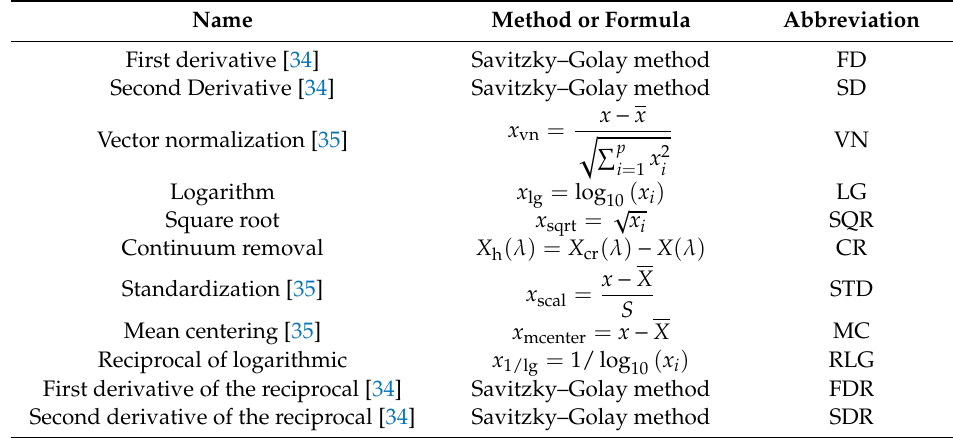
Table 1. These transformations were performed in MATLAB R2015b (MathWorks), except that CR was performed in ENVI 5.1 (Exelis Visual Information Solutions, Incorporated, Harris Corporation). Table 1. Spectral transformation